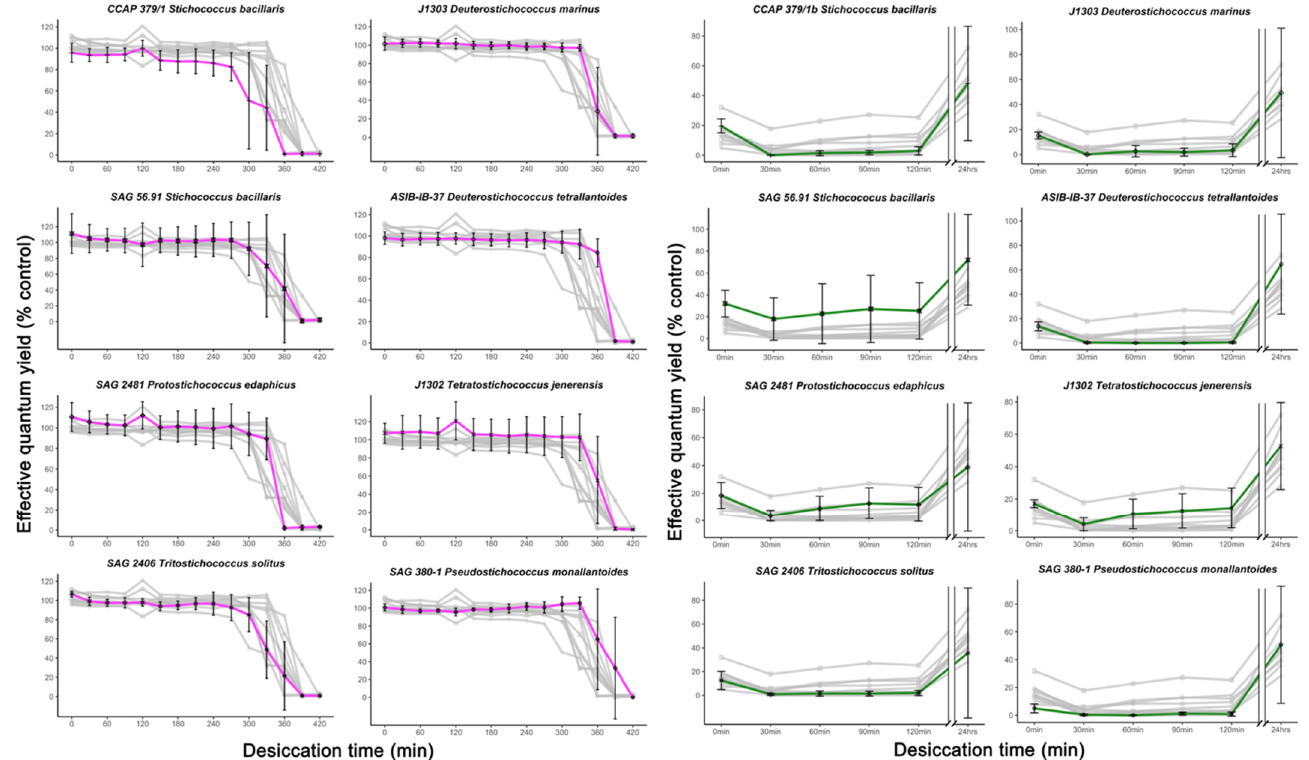
Figure 6. Concentrations are expressed as µmol g − 1 dry weight (DW). Comparison of Y(II) after desiccation and rehydration in selected Stichococcus -like strains. The strains are representative of the major lineages within the clade. Magenta lines show average effective quantum yield (Y(II)) per strain during dehydration, while green lines show the average Y(II) in the recovery phase; grey lines in the background represent the other strains for comparison. Error bars represent standard deviation ( n = 3).